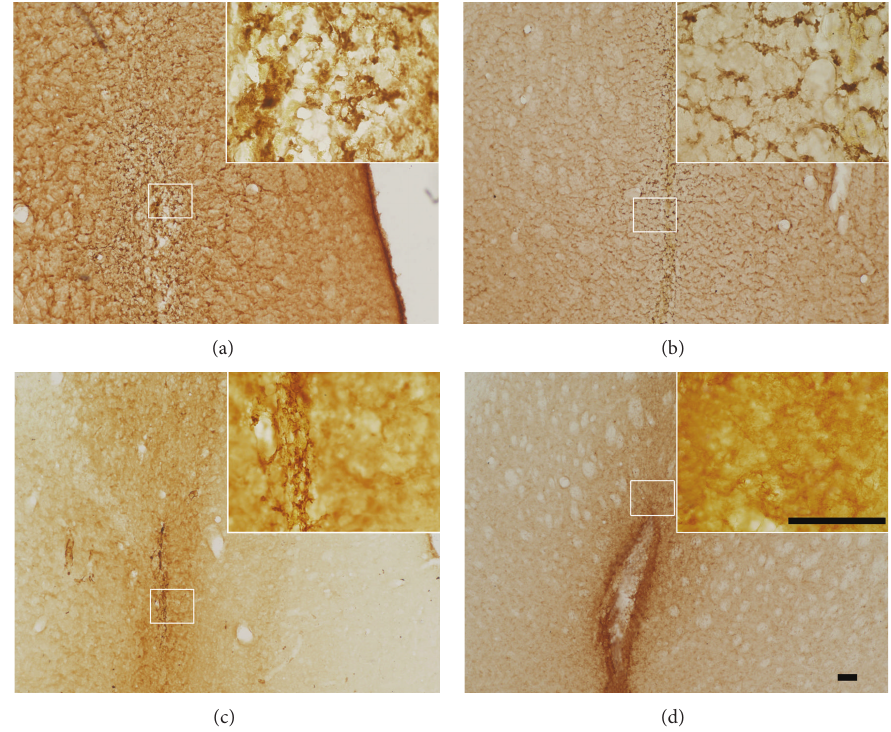
Figure 8: Immunohistochemistry of fibroblasts expressing TH in the striatum (DAB, bar = 100 𝜇 m). A large number of TH-positive cells are observed in the left striatum around the pin track in fibroblasts (TH) group, but there are no positive cells in either hemispheres of the rAAV2-hGAD65 group. The number of TH-positive cells decreased according to posttreatment time: 4 weeks (a), 8 weeks (b), and 16 weeks (c). There was no TH-positive cell around the pin track in the left striatum of fibroblast at 4 weeks after treatment (d).